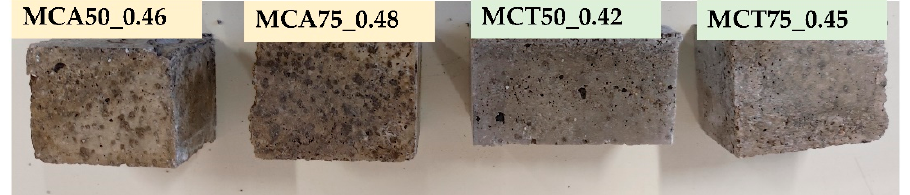
Figure 1. Specimens cured for 28 days: MCT75_0.45, MCT50_0.42, MCA75_0.48 and MCA50_0.46.